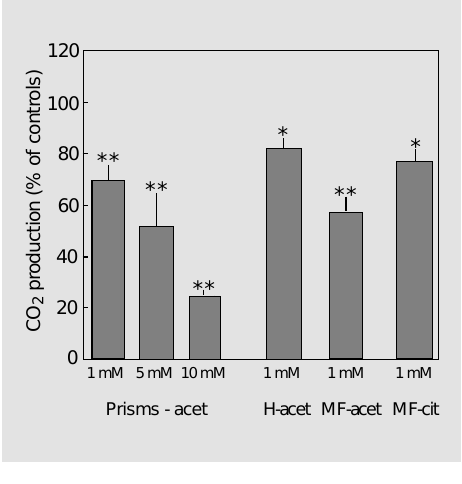
Figure 2. Effect of DL-2-hydroxy- butyric acid (1-10 mM) on in vitro lipid synthesis from 14 C-acetate in cerebral cortex of 30-day-old rats. Values (means ± SEM) re- fer to percentage of 14 C-lipid production relative to controls (N = 4 to 8 animals). 2 h, two-hour incubation; H, homogenate;